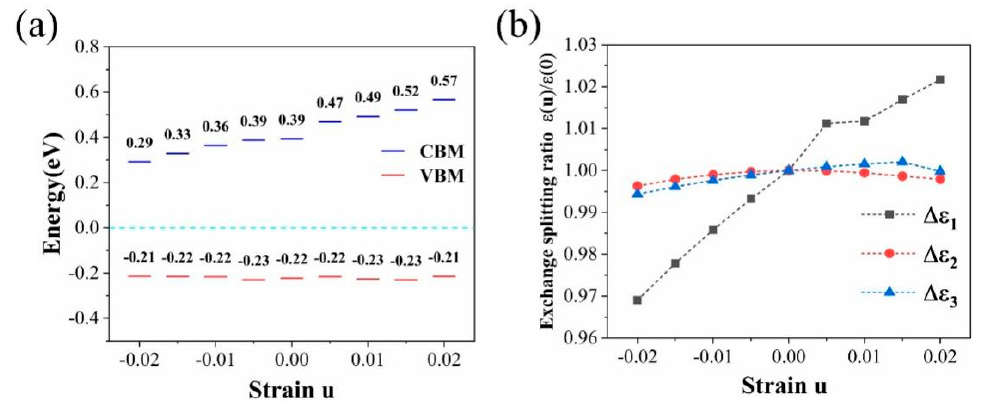
Figure 5. ( a ) Bandgap and ( b ) the exchange-splitting for V sCF -fluorographene with the uniaxial strain applied in zigzag direction.